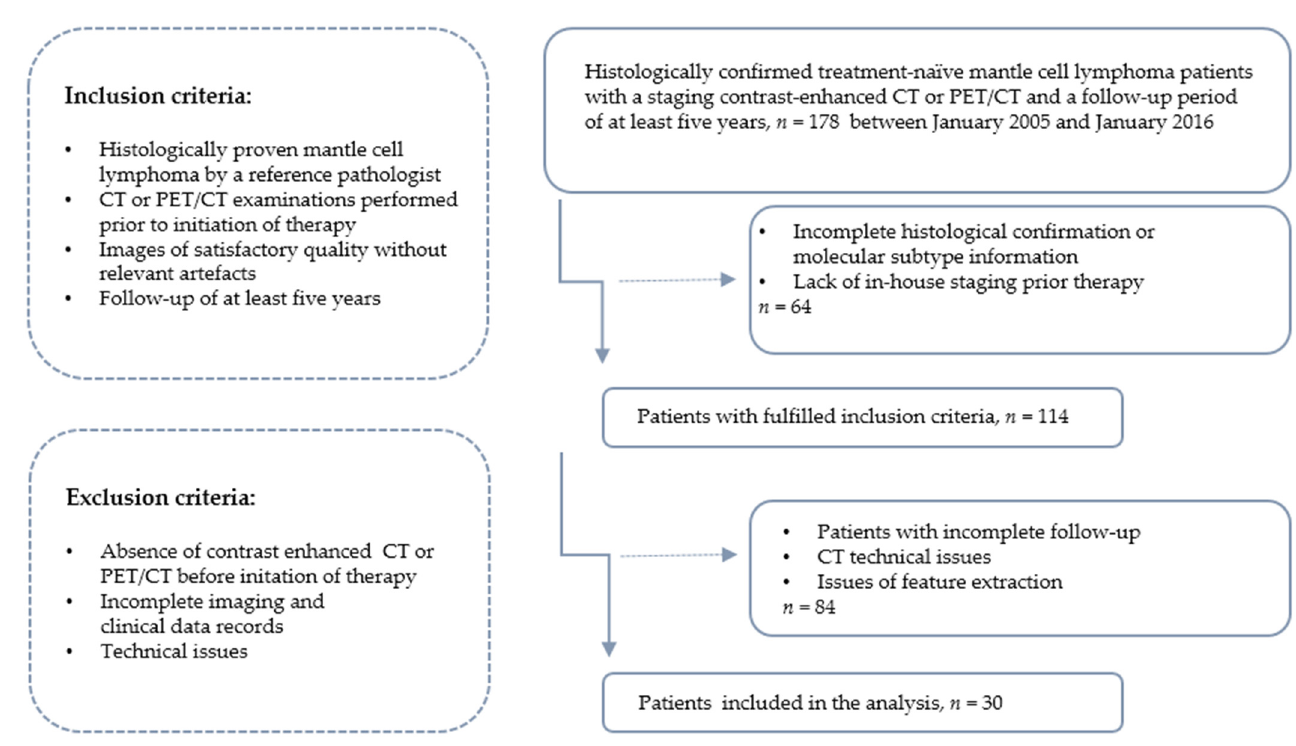
Figure 1. Recruitment pathway of the study.